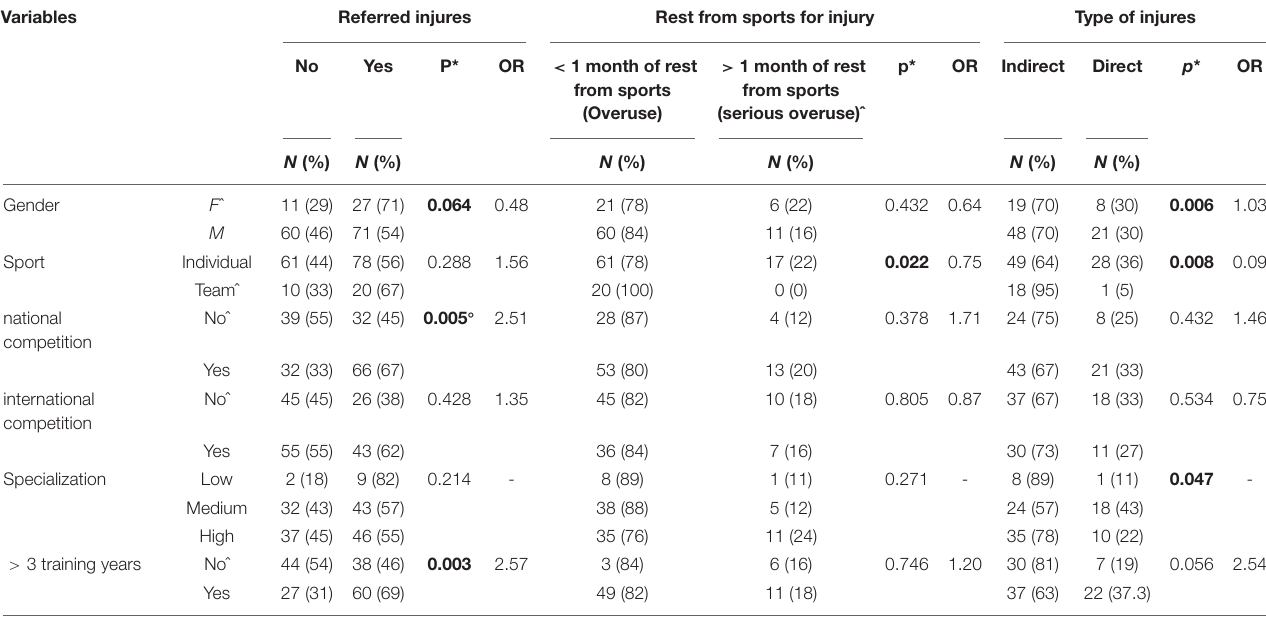
TABLE 2 | Univariate analysis in “reffered injury,” “rest from sport for injury” and “type of injury”.